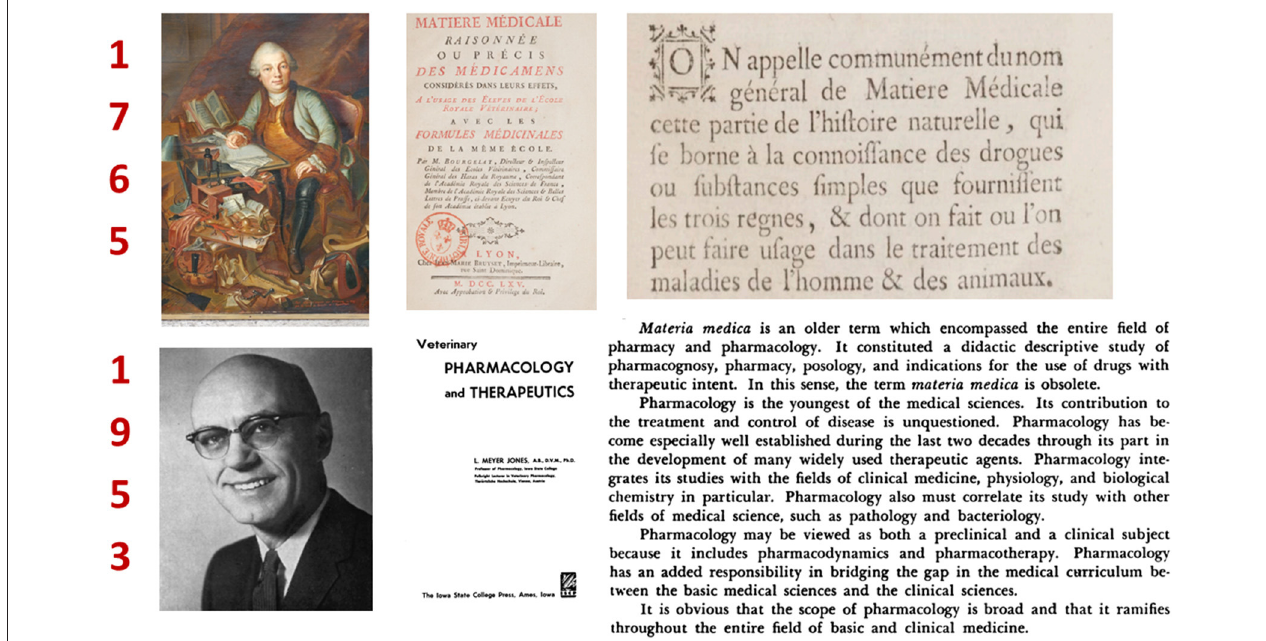
FIGURE 1 | Bourgelat (1) vs. Jones (2): definition of Materia Medica. Definition of Materia Medica by Bourgelat: It is commonly named by the generic name of “Materia Medica,” that part of natural history, which I limit to the knowledge of drugs and simple substances supplied by the three kingdoms, and which are or can be used in the treatment of diseases of man and animal. The three “kingdoms” were animal, vegetable, and mineral. In western pharmacopeias, plants comprised 80% of simples (single substance or products produced by mixing plants) while the remaining 20% was divided equally between substances of animal and mineral origin